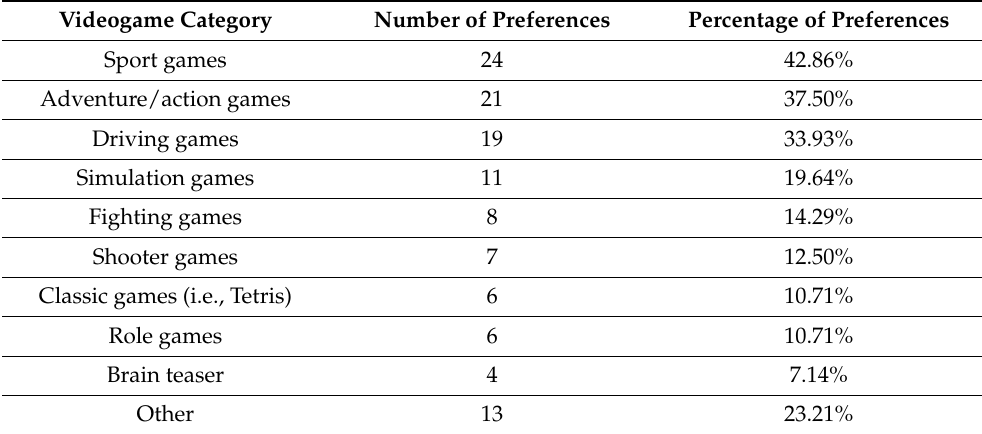
Table 4. Categories of videogames preferred by children with neurological impairments as reported by their parents.